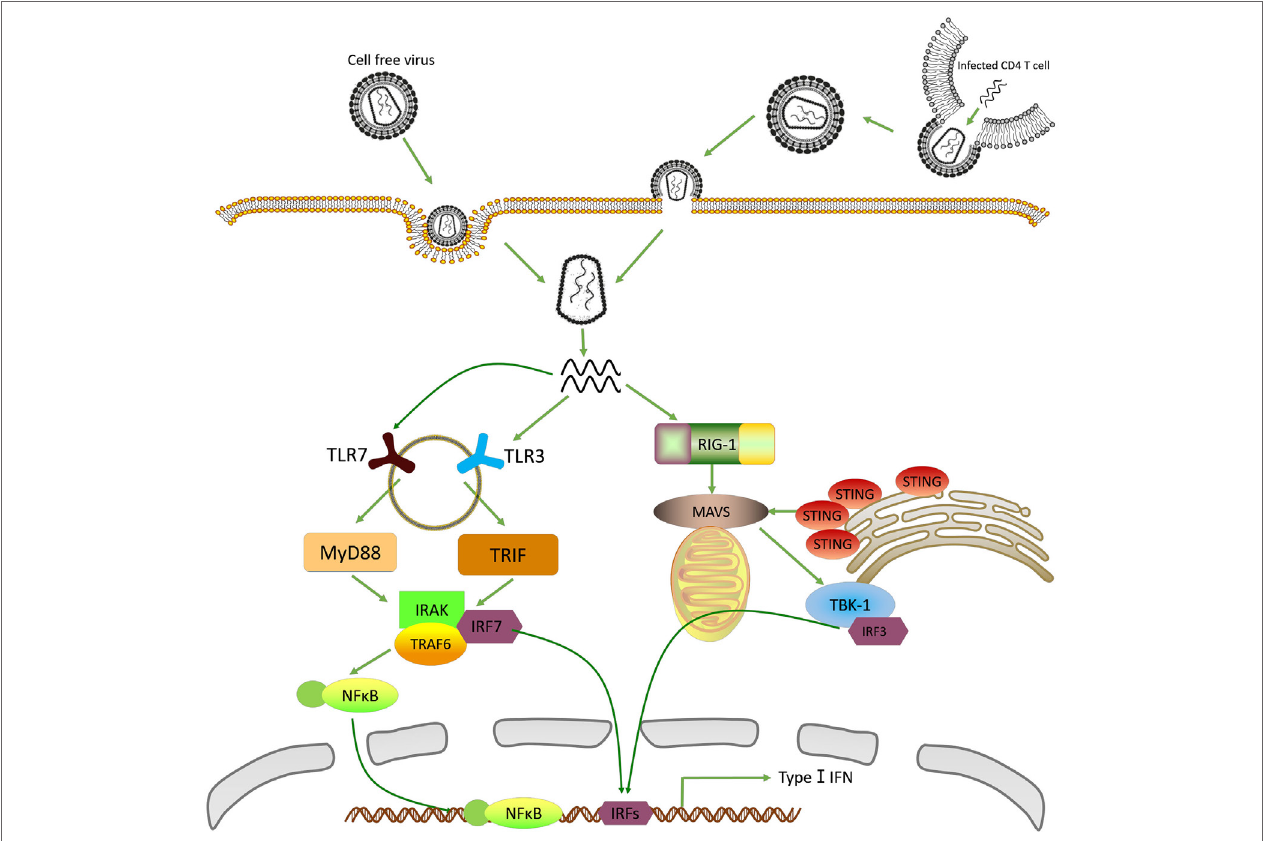
FigURe 1 | Recognition of human immunodeficiency virus 1 (HIV-1) by innate immune system. In plasmacytoid dendritic cells (pDCs), cell-free HIV is taken up through endocytosis while cell-associated virus enters into pDCs by fusion and endocytosis. The single-strand RNA (ssRNA) released from virus is recognized by TLR3 and TLR7. Then the activated toll-like receptors (TLRs) stimulate MyD88 and TRIF signal pathway, recruit NF- κ B and interferon-regulatory factor (IRF)-7, respectively, to trigger type-I interferons (IFN-I) production. In macrophages and CD4 + T cells, HIV-1 enters cells mainly through fusion and endocytosis. But the ssRNA is detected by retinoic acid-inducible gene (RIG)-I, which stimulates mitochondrial antiviral signaling protein (MAVS)–IRF-3 dependent pathway, and next moderately induces the expression of